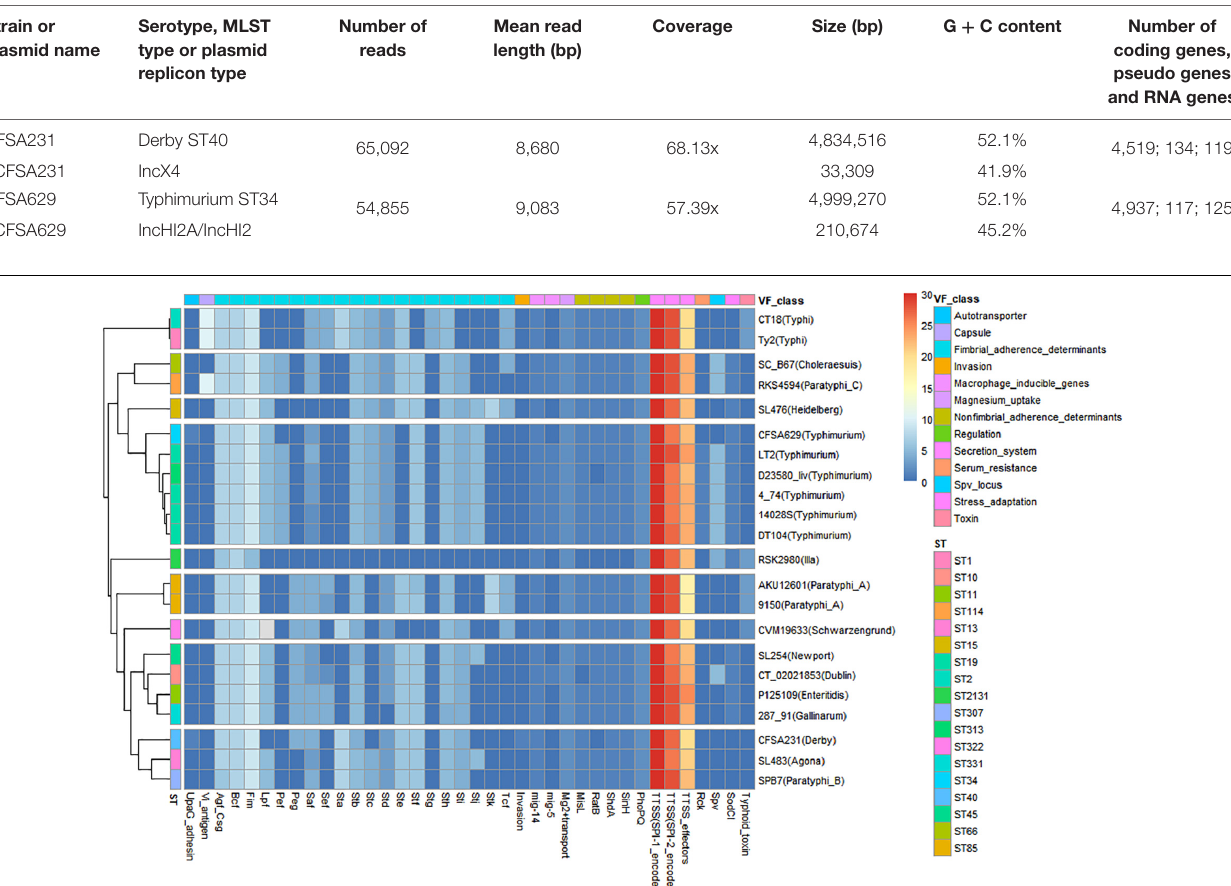
TABLE 3 | Genome sequence features for CFSA231 and CFSA629.